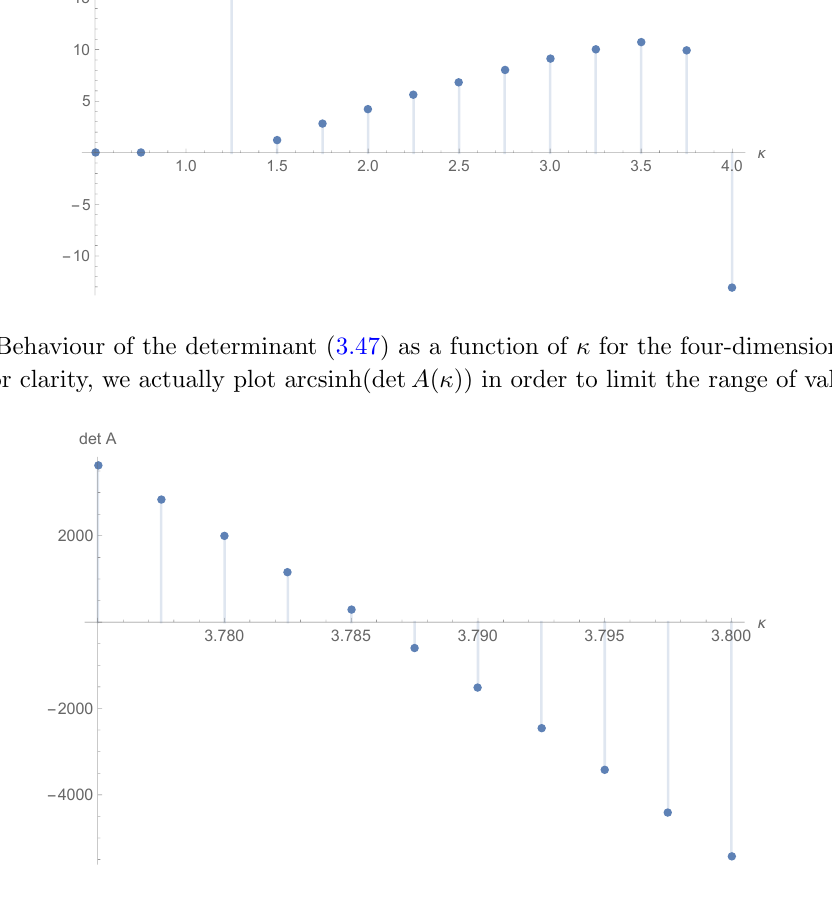
Figure 2 . Behaviour of det A near the last crossing in the elliptic four-dimensional